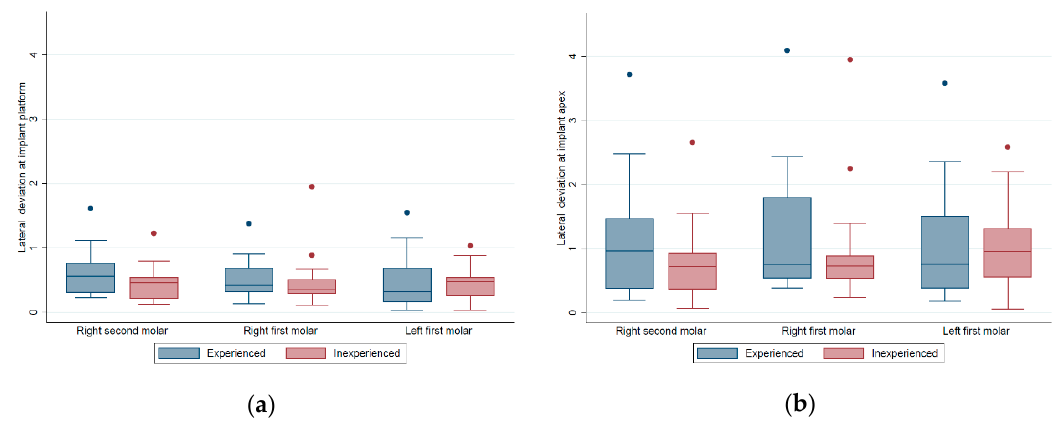
Figure 8. Box plots of the lateral deviation at the implant: ( a ) platform and ( b ) apex of experienced and inexperienced operator group.